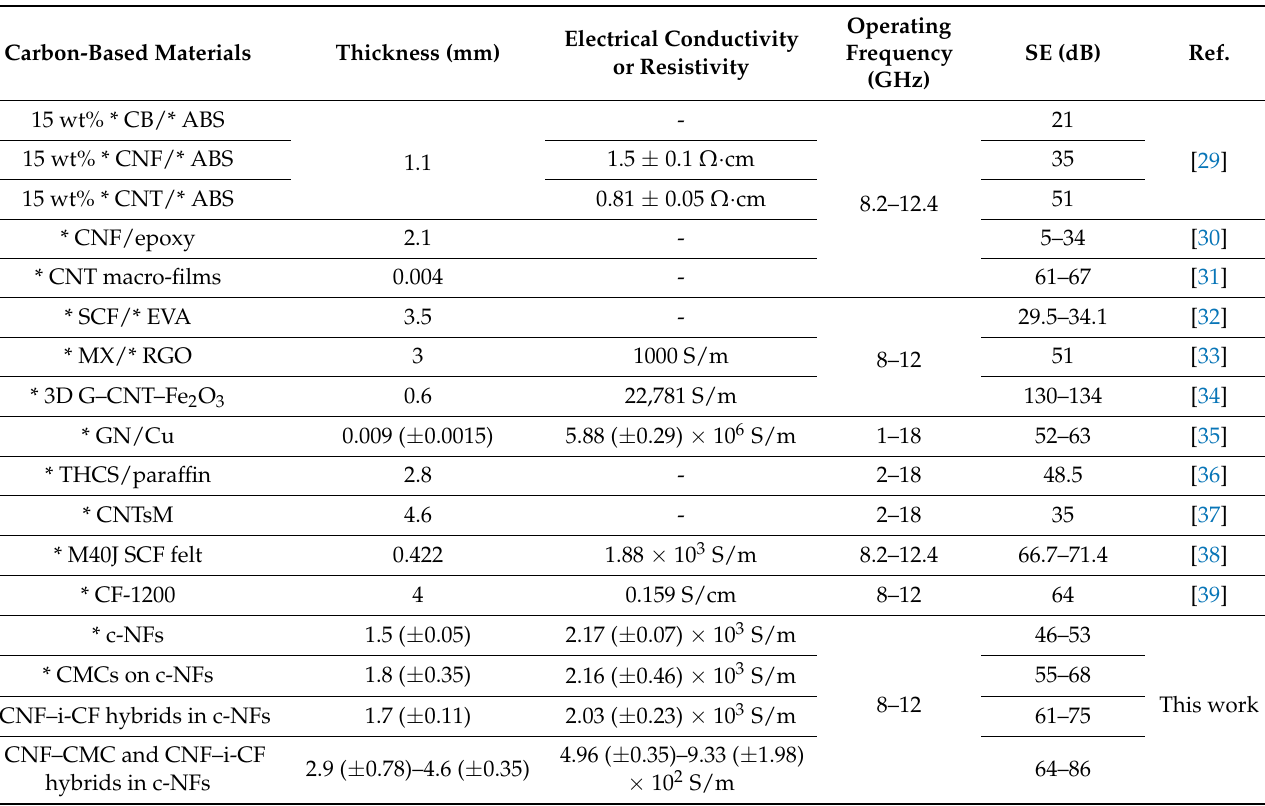
Table 3. EMI SE of carbon-based